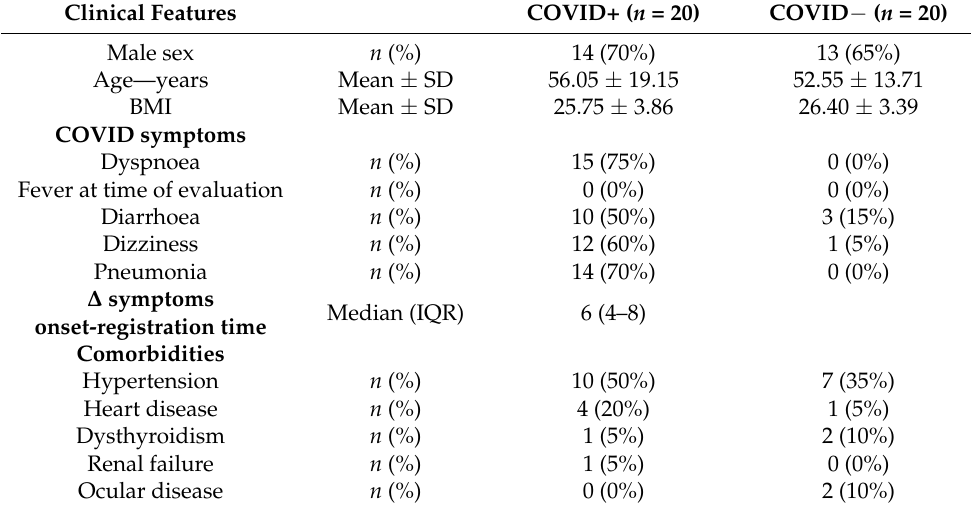
Table 1. Clinical and demographic feature of COVID+ and COVID − groups. Categorical variables are expressed as number ( n ) and percentage (%). Numerical variables are expressed as mean ± standard deviation, since they showed a normal distribution in a normality test (i.e., Shapiro-Wilk test). Clinical